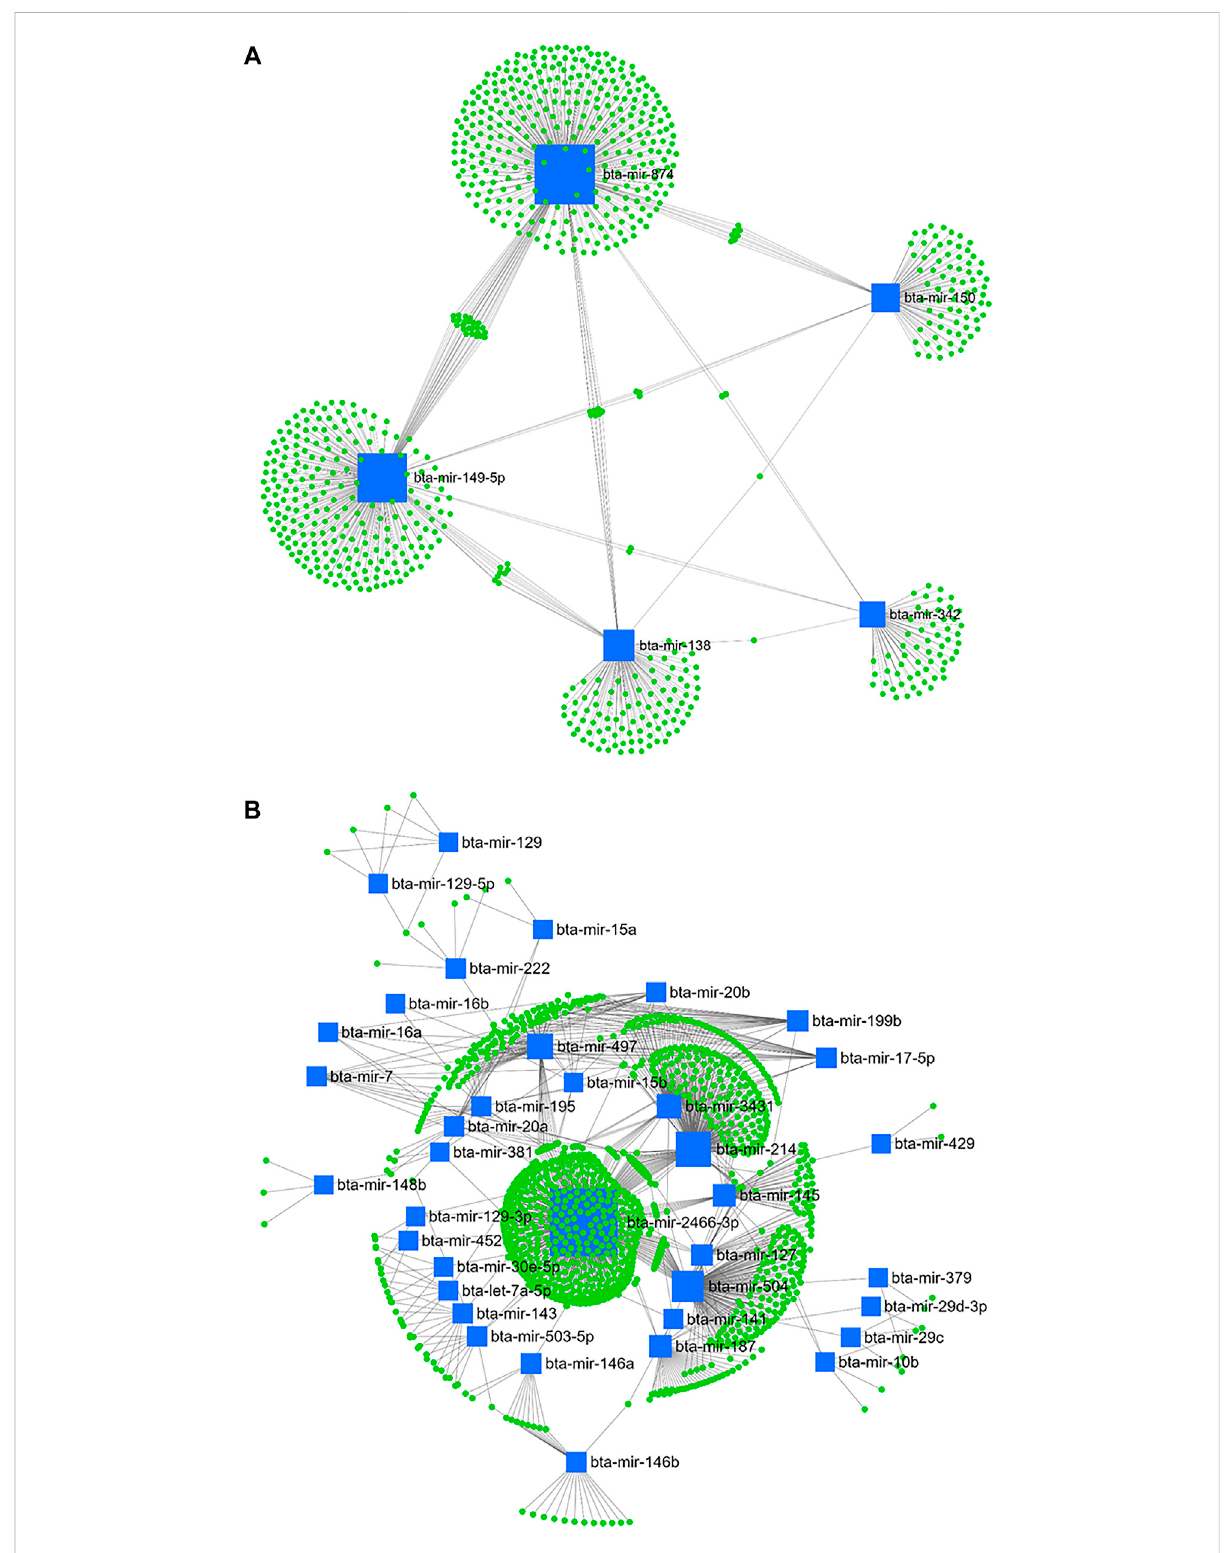
FIGURE 9 miRNA/mRNA network analysis. The regulation network of downregulated (A) and upregulated (B) miRNAs and predicted target mRNAs in d+1/-21 is illustrated by Cytoscape software. The nodes represent the mRNA (green), and the boxes represent the miRNA (blue). The box size corresponds to the centrality and betweenness of miRNA in constructing the